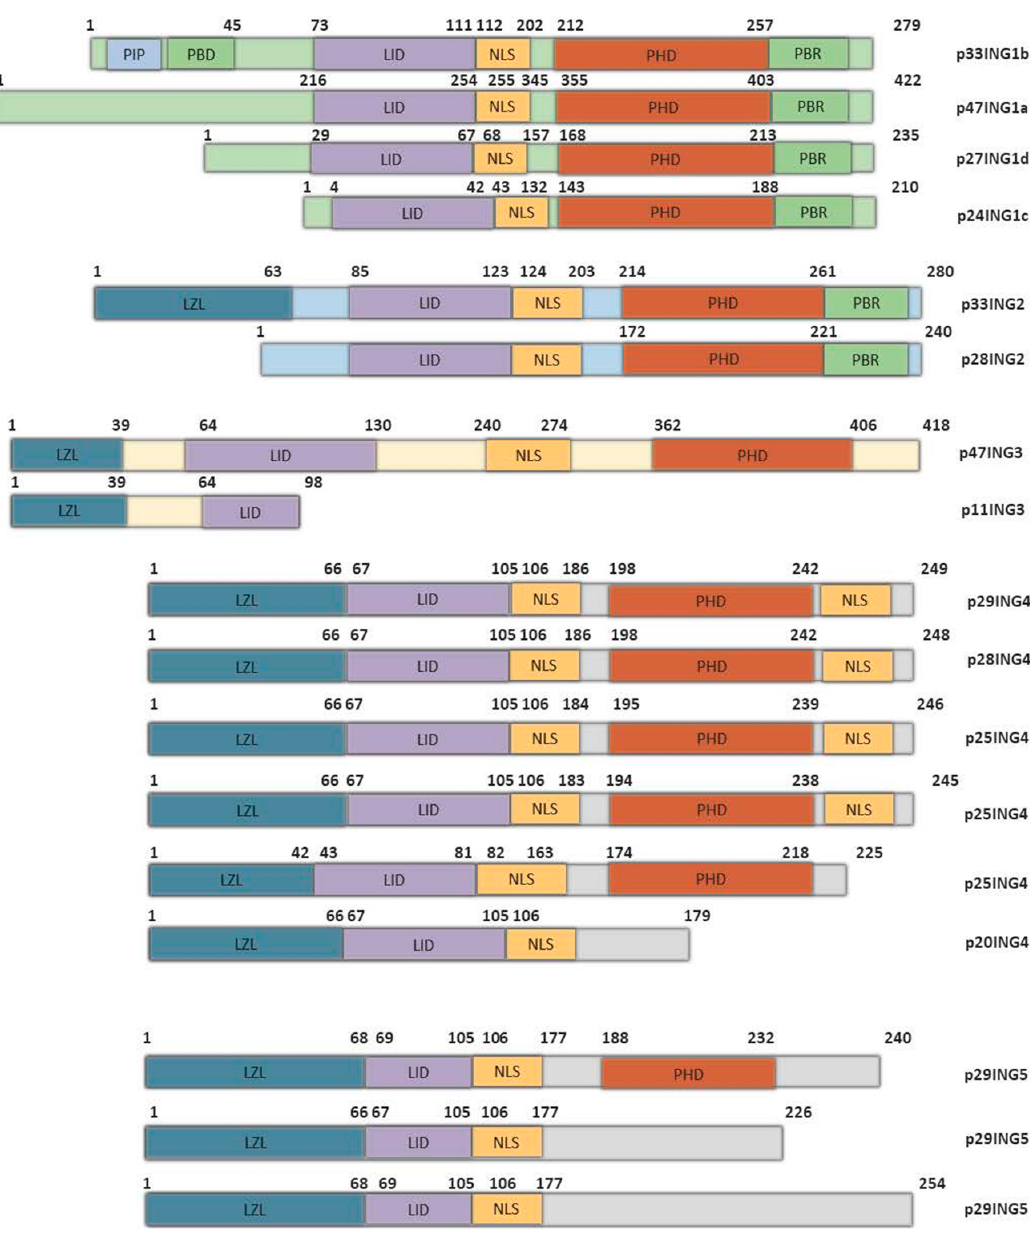
Figure 1: Domains of ING protein isoforms. ING proteins are well conserved throughout evolution. The plant homeodomain (PHD) allows these proteins to bind to the H3K4me3 histone mark and is present in all INGs. The lamin interacting domain (LID) is important so they can interact with lamin A and, at least for ING1, maintain nuclear morphology. Located within the nuclear localization sequence (NLS) that promotes translocation of the ING proteins to the nucleus by binding the karyopherin proteins are small, basic nucleolar targeting sequences (NTS). These direct ING1 to the nucleoli under conditions of stress, which promotes apoptosis. The NLS can also bind the p53 tumor suppressor. Proliferating cell nuclear antigen protein (PCNA) has been shown to bind specifically to ING1b via the PCNA-interacting protein (PIP) motif, and this interaction is also important for promoting apoptosis in response DNA-damage-induced stress. The polybasic region (PBR) is present only in ING1 and ING2. This motif can interact with both bioactive signaling phospholipids (PIs) and ubiquitin (Ub), the latter of which might serve to stabilize multi-monoubiquitination p53. The function of the partial bromodomain (PBD) has not been defined, but like the leucine zipper-like (LZL) region, may promote ING protein multimerization and / or interaction with other members of the HAT and HDAC complexes that ING proteins target to the H3K4Me3 histone